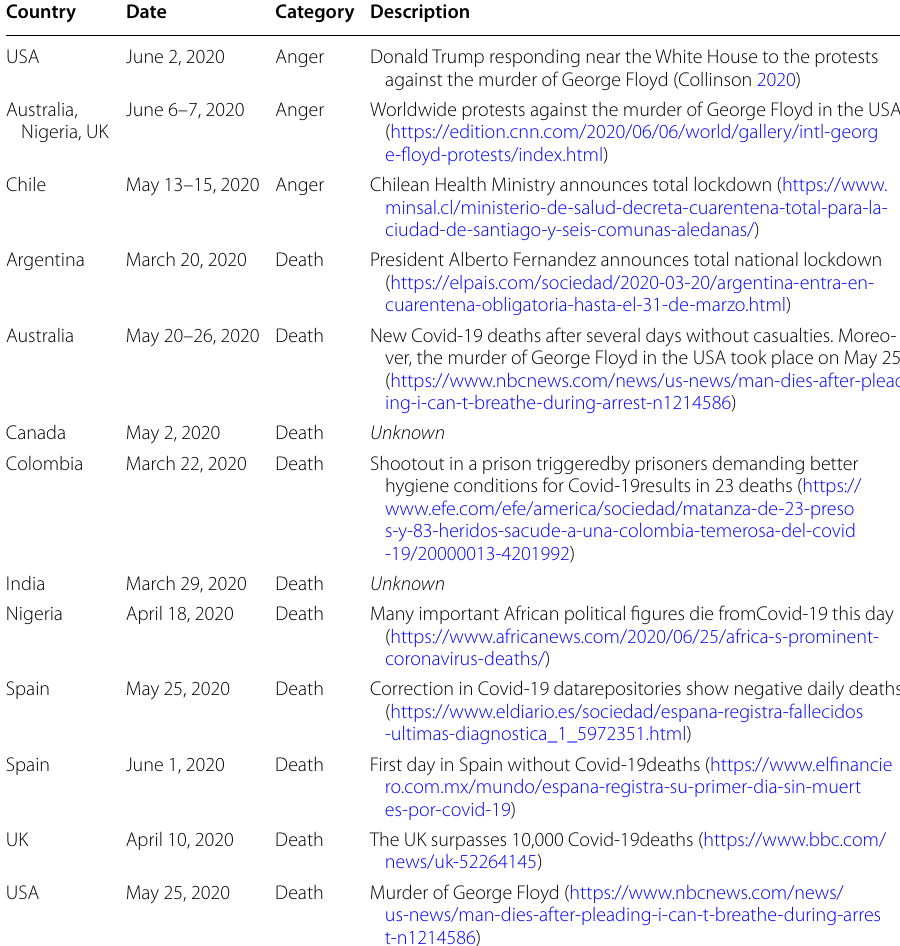
Table 8 A list of plausible explanations for anomalous peaks observed in Fig. 1